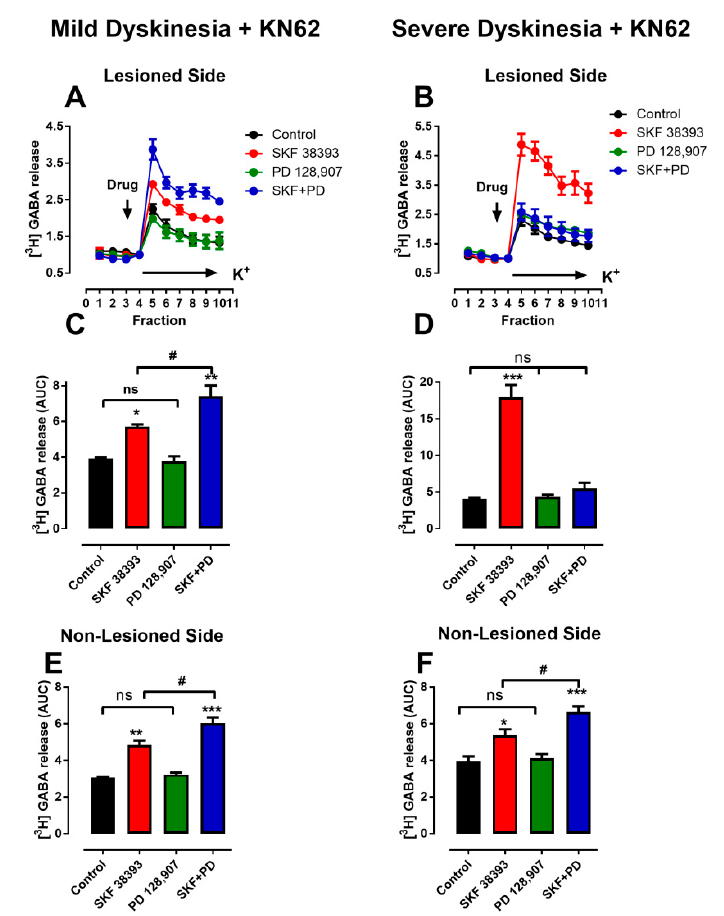
Figure 4. Effects of D3R activation on D1R stimulation on K + -depolarization-induced [ 3 H]-GABA release in SNr slices. ( A , B ) Temporal courses of K + -depolarization-induced responses. Vertical arrow indicates time when ligand perfusion was initiated; horizontal bar indicates initiation of perfusion with 20 mM K + solution. ( C , D ) Results for lesioned side of animals with mild dyskinesia and severe dyskinesia, respectively. ( E , F ) Non-lesioned side of animals with mild dyskinesia and severe dyskinesia, respectively. Note: # p < 0.05, * p < 0.05, ** p < 0.01, and *** p < 0.001 in comparison with control; ns is not significant. Values mean ± standard error, n = 3 experiments, five replications per experiment.